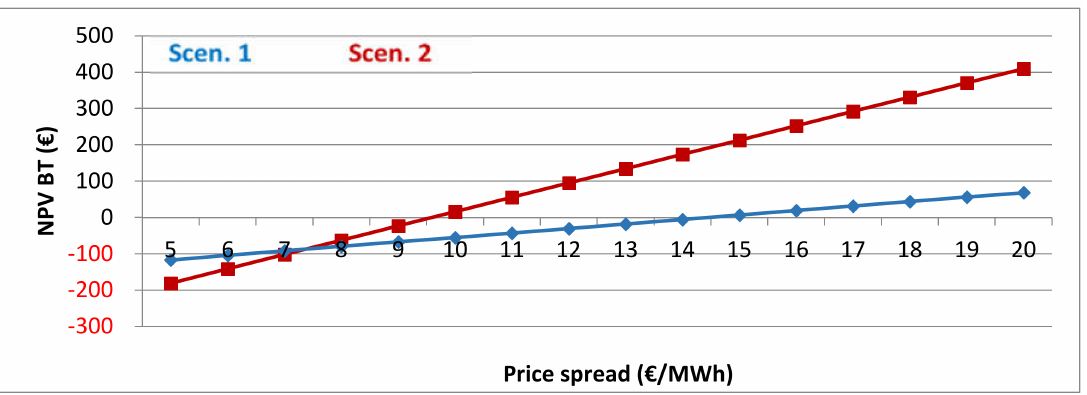
Figure 11. Net present value before tax as a function of the price spread, Scenarios 1 and 2, excl. flooding